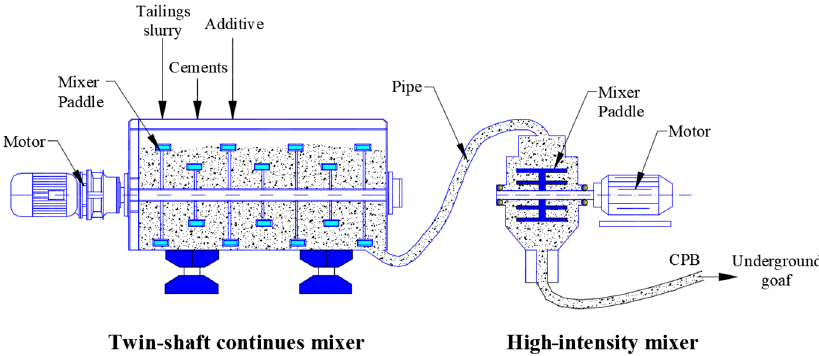
Figure 2. The high-intensity mixing technology of cemented paste backfill (CPB).